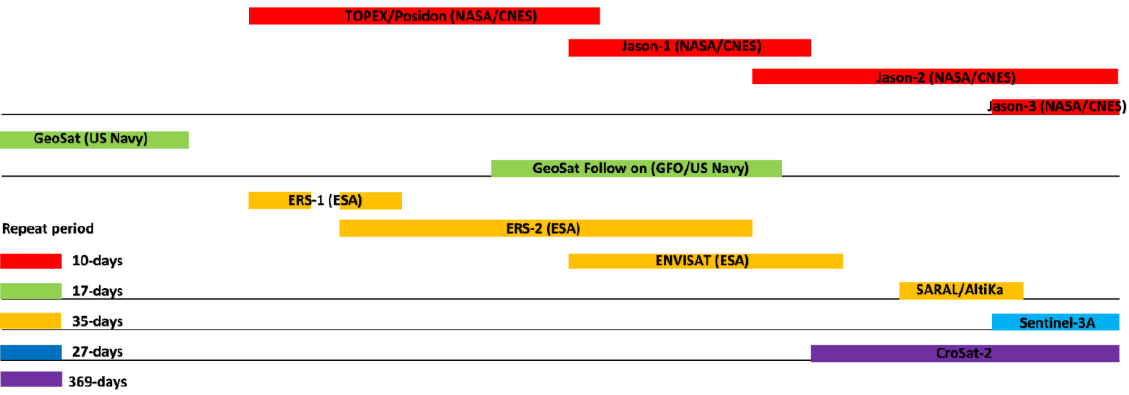
Figure 2. Temporal coverage of the available altimetry data products used in this study. The datasets start in April 1985 and end in September 2018.